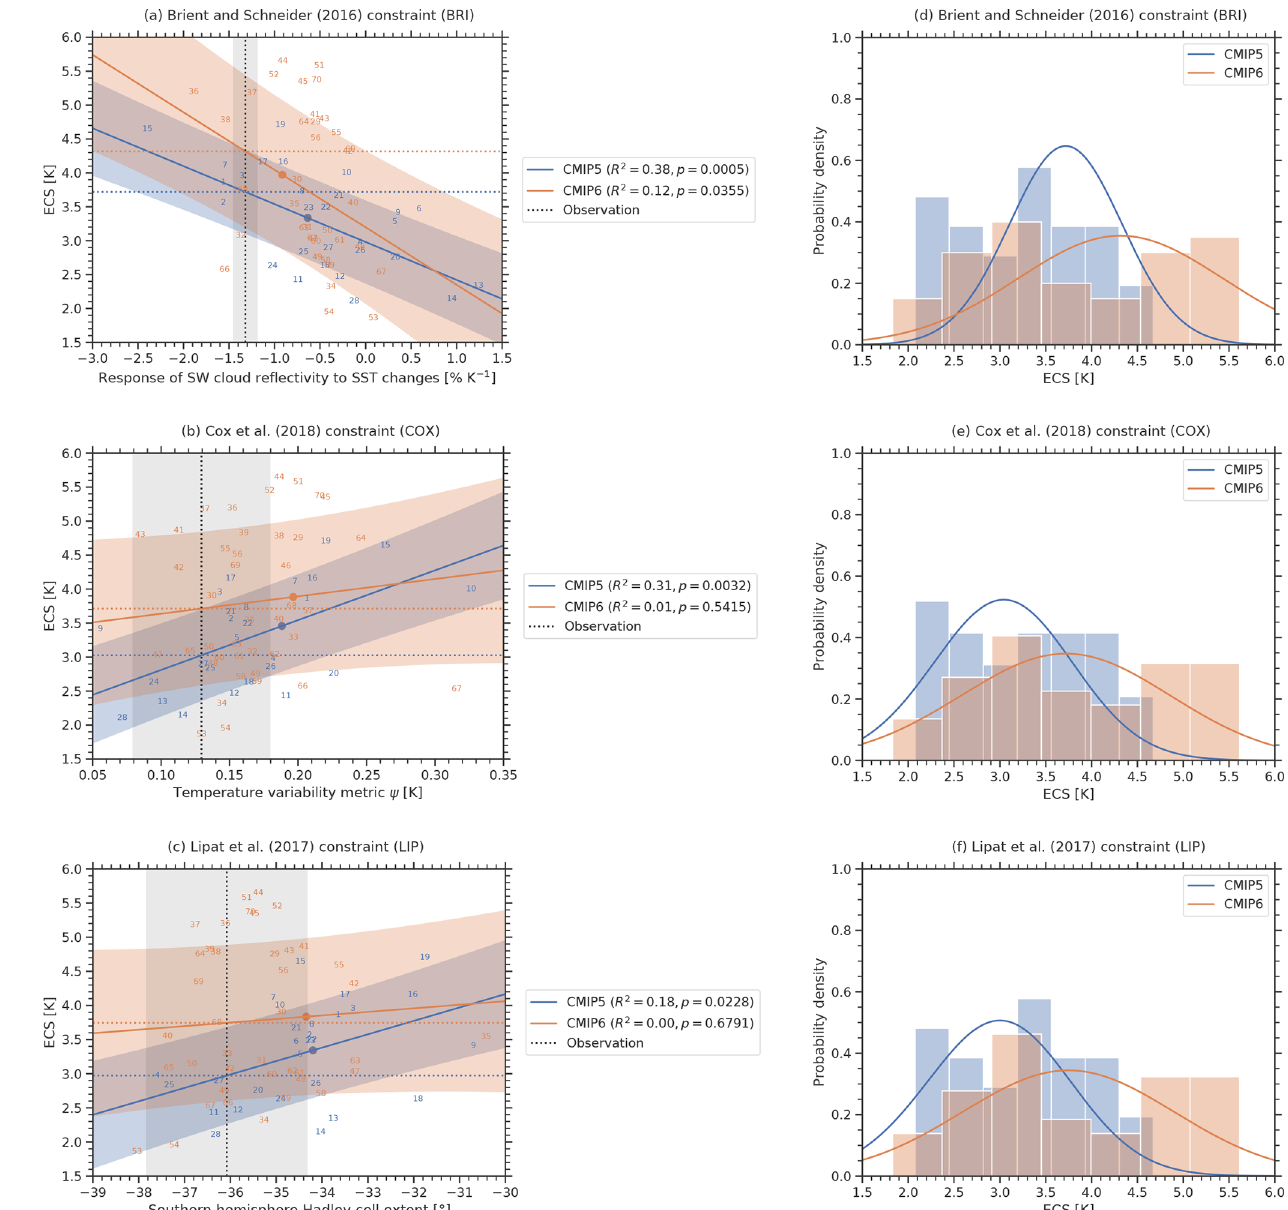
Figure 2. Emergent constraints BRI, COX, and LIP applied to the CMIP5 ensemble (blue) and CMIP6 ensemble (orange). (a–c) Emergent relationships (solid blue and orange lines) for the CMIP models (numbers for individual models are specified in Tables A1 and A2). The shaded areas around the regression lines correspond to the standard prediction errors (Eq. 3), which defines the error in the regression model itself. The vertical dashed black line corresponds to the observational reference (see Table 1 for details on the individual observational datasets used) with its uncertainty range given as standard error (gray shaded area). The horizontal dashed lines show the best estimates of the constrained ECS for CMIP5 (blue) and CMIP6 (orange). The colored dots mark the CMIP5 (blue) and CMIP6 (orange) multi-model means. The p value in the legend corresponds to the hypothesis test introduced in Sect. 2.3 and describes the probability to obtain an absolute correlation coefficient | r | or higher under the null hypothesis that the true underlying correlation coefficient between the predictor and ECS is zero. (d–f) Probability densities for the constrained ECS following Eq. (6) (solid lines) and the unconstrained model ensembles (histograms). Note that for each individual emergent constraint, a different subset of climate models is used due to the availability of data (see Tables A1 and A2 for details). Thus, these histograms may differ for the different